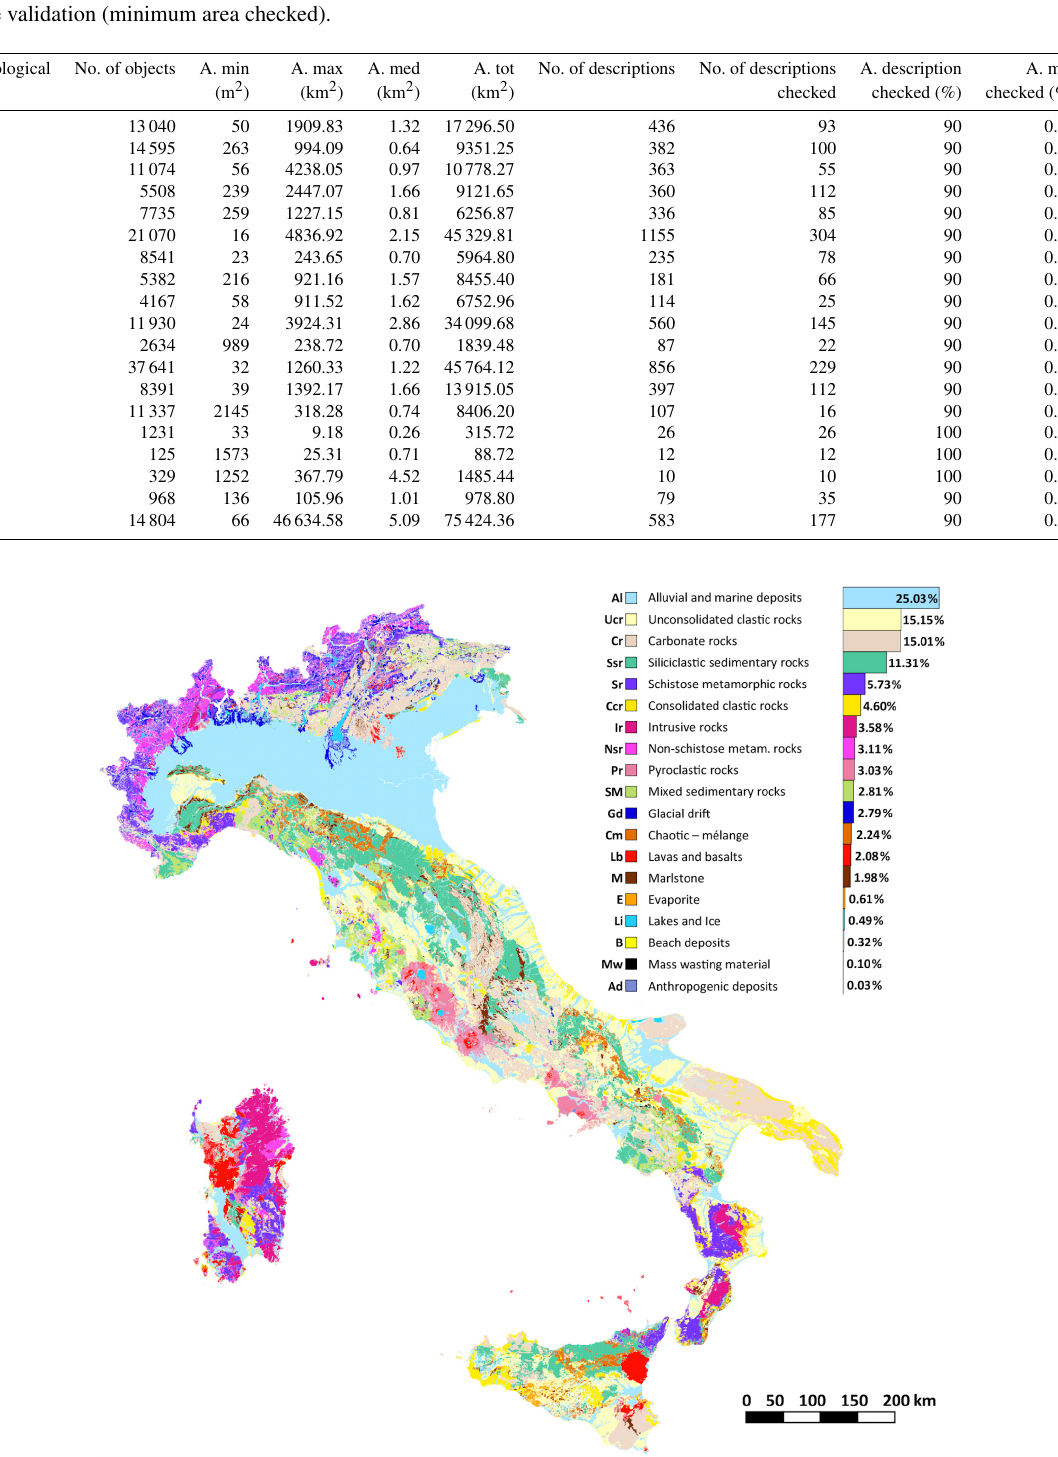
Figure 5. Map of Italy showing the 19 lithological classes identified with both the short ID and the extended name.